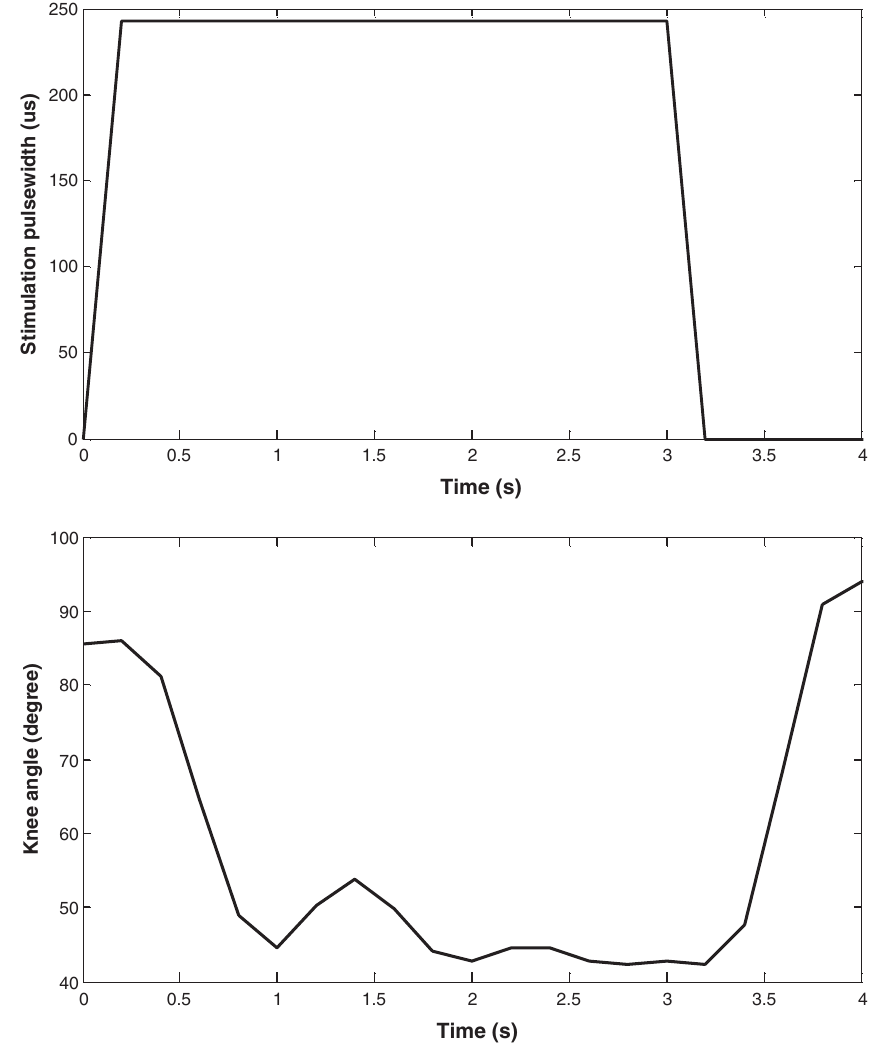
Fig. 3. Stimulation pulse-width (input) and the knee angle